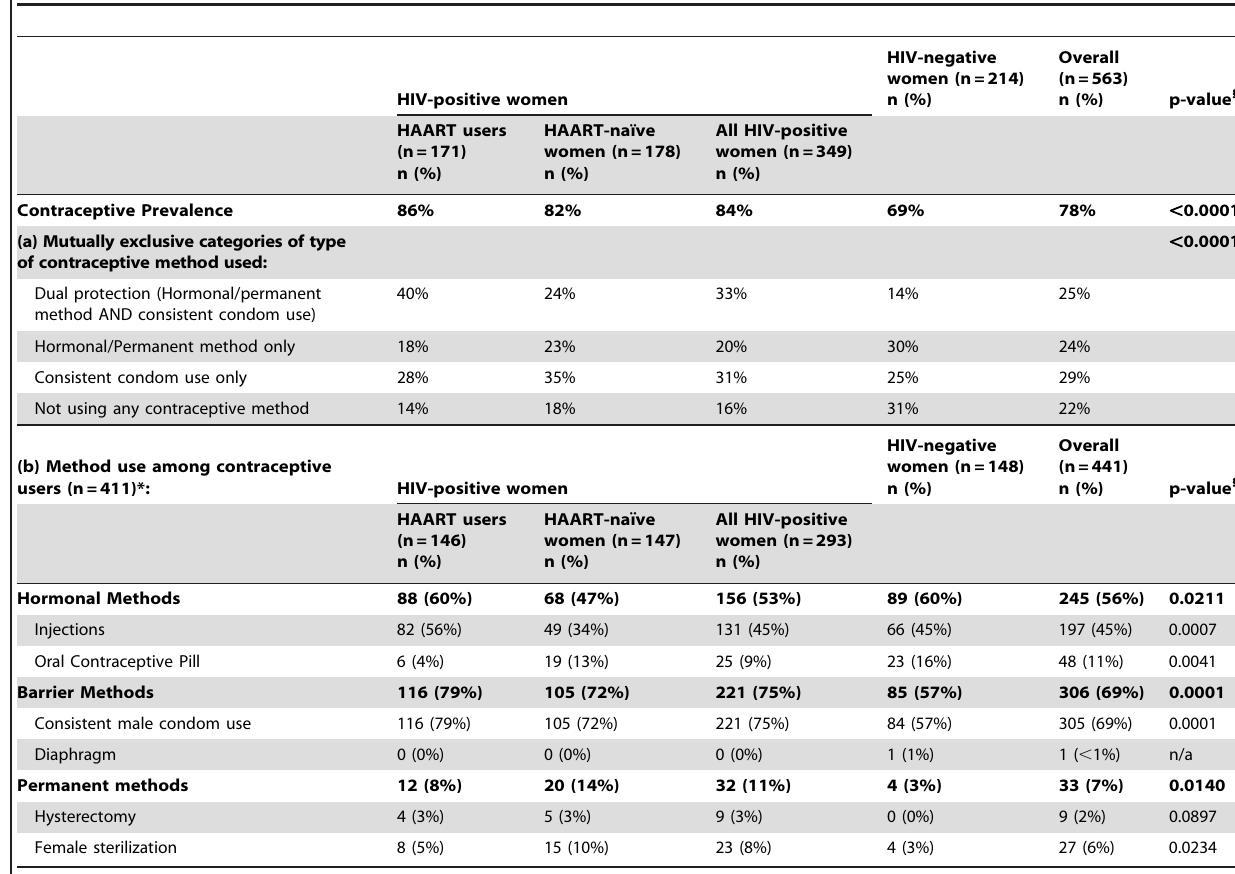
Table 2. Types of contraceptive methods used by HIV-positive (HAART users and HAART-naı¨ve) and HIV-negative women (aged 18-44 years, currently sexually active and non-pregnant) in Soweto, South Africa.